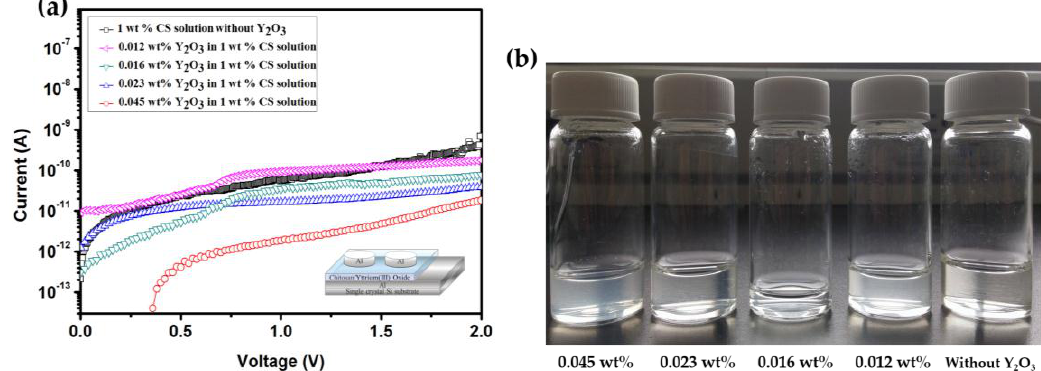
Figure 3. ( a ) Leakage current of the thin films measured with various concentrations of Y 2 O 3 solutions (without Y 2 O 3 , 0.012 wt %, 0.016 wt %, 0.023 wt %, 0.045 wt %) in 1 wt % chitosan solution ( b ) Pictures showing the various weight percentages of Y 2 O 3 in the mixed solution.